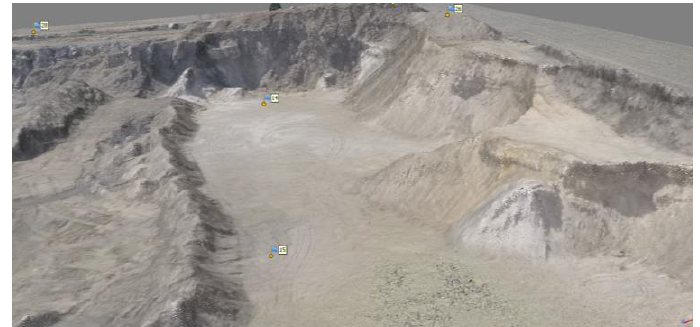
Figure 12. Dense point cloud of the study site.